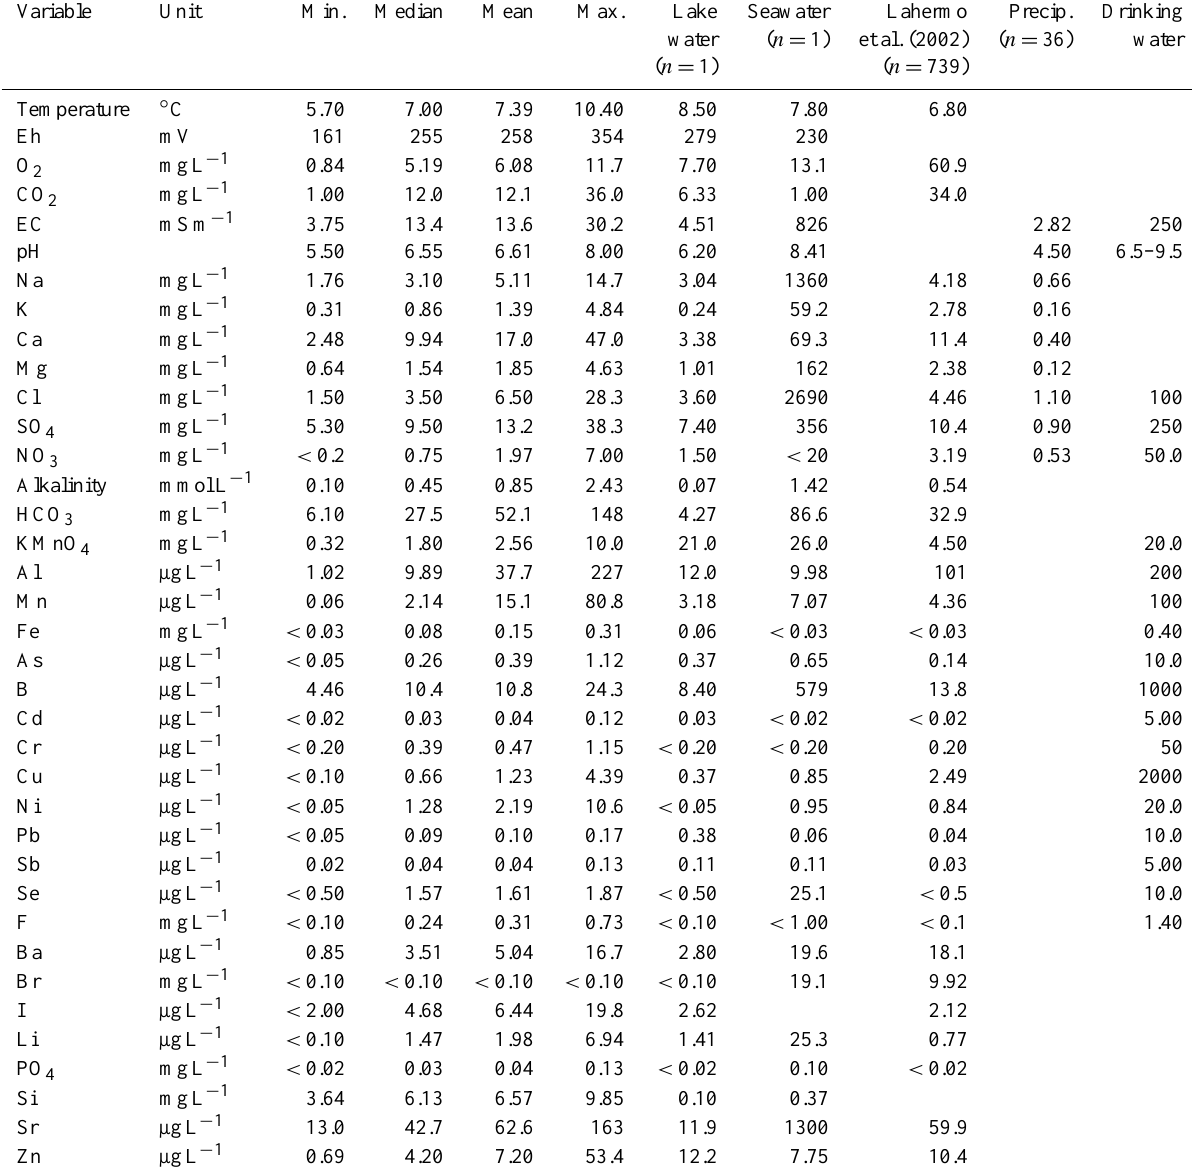
Table 2. Characteristics of groundwater in the Santala area, Hanko (number of samples n = 32) compared with data from lake water, seawater, the median values from Lahermo et al. (2002) and precipitation from Vuorenmaa et al. (1999) and Järvinen and Vänni (1997, 1996), and safe drinking water (STM,